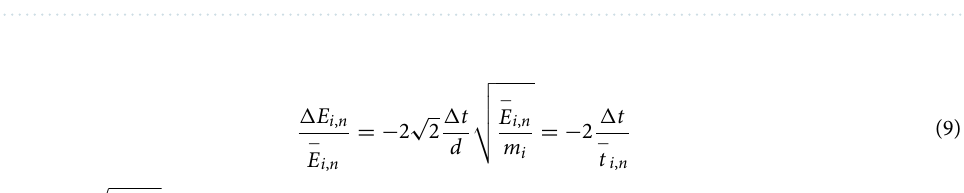
Figure 8. Charge collection efficiency (CCE) of the diamond detector as a function of energy. Fit curve is also reported in the